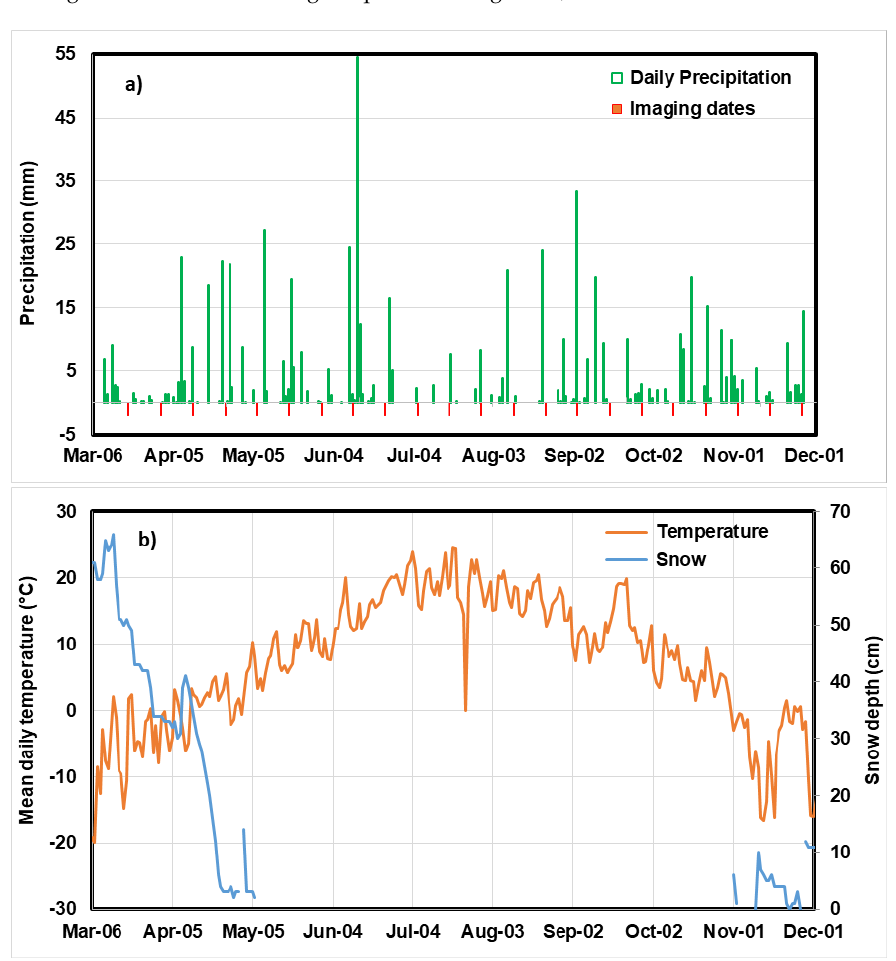
Figure 2. Meteorological condition of the study area in 2019, obtained from the Earlton Climate Station (ID 6072230), Ontario, Canada: ( a ) daily precipitation; ( b ) mean daily temperature and snow